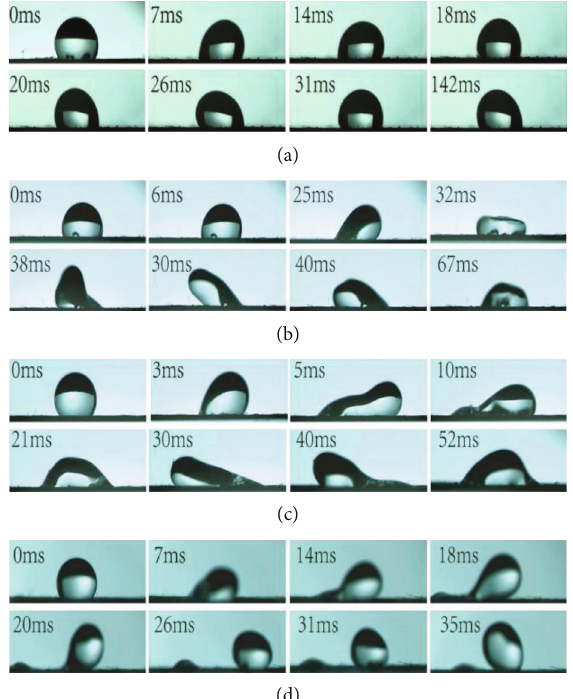
Figure 10: Under the horizontal vibration amplitude of 2mm, di ff erent frequency conditions, the movement of droplets on the surface of